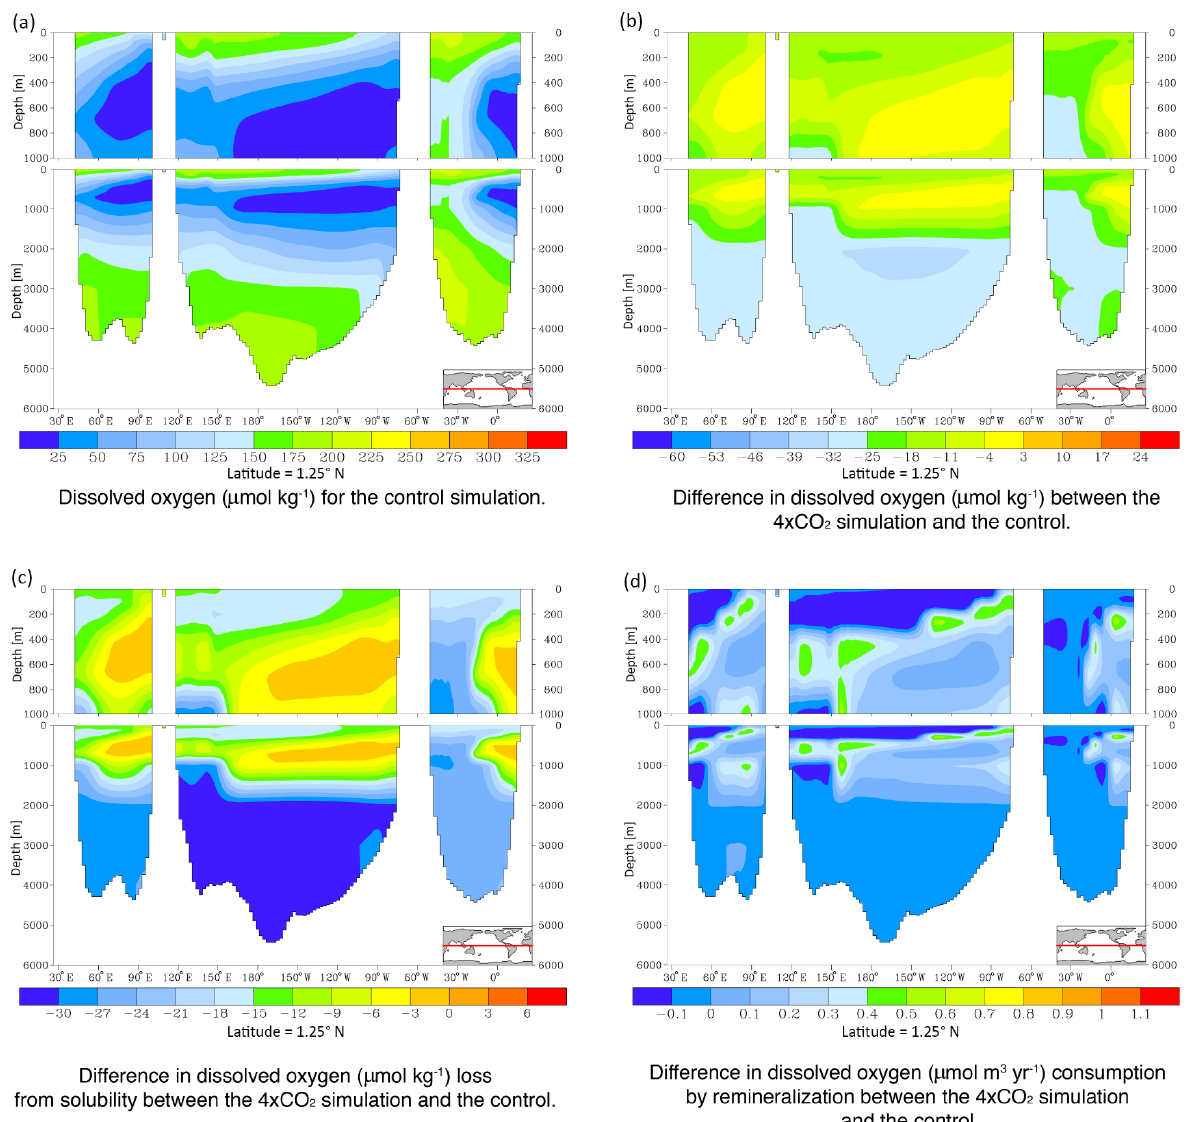
Figure 11. Mechanisms for oxygen loss in the OMZs at 4 × CO 2 . (a) Reference simulation. (b) The difference in DO concentrations between 4 × CO 2 and the reference simulation. (c) The difference in DO lost due to changes in solubility between 4 × CO 2 and the reference simulation. (d) The increase in oxygen consumption due to remineralization of organic carbon between the 4 × CO 2 and reference